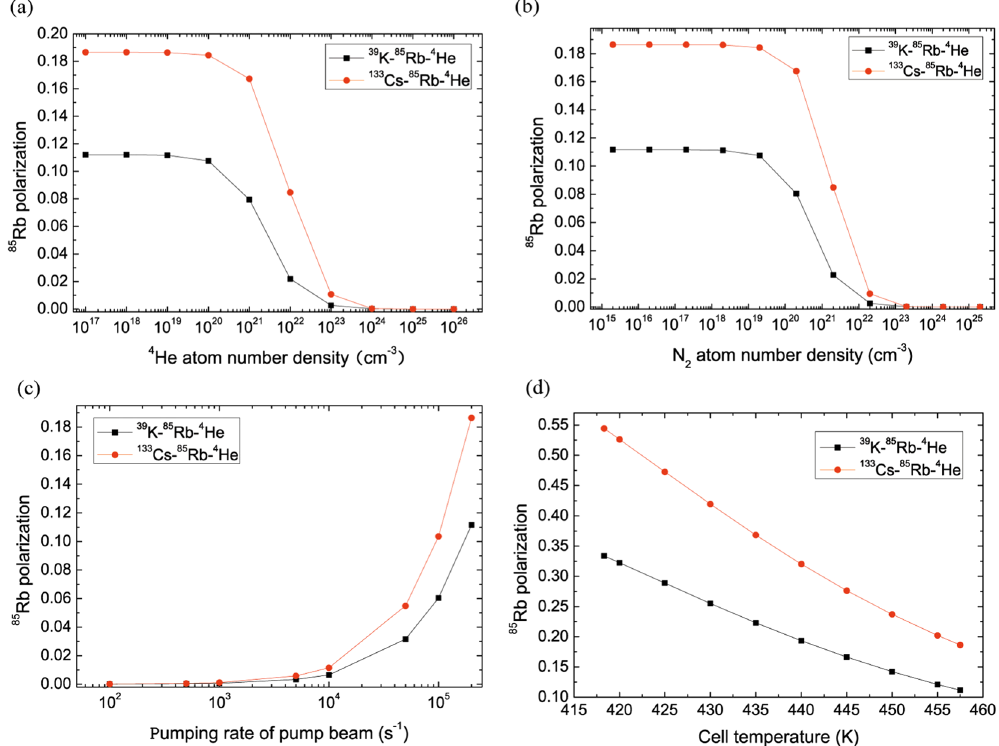
Figure 2. The 85 Rb polarization of 39 K ( 133 Cs)- 85 Rb- 4 He magnetometers varies with the number density of the buffer gas ( 4 He), the pumping rate of pump beam, number density of the quench gas N 2 and the cell temperature respectively. ( a ) 85 Rb polarization almost does not vary with the increasing 4 He number density when 4 He number density is smaller than a critical value about 10 20 cm − 3 in 39 K - 85 Rb- 4 He (black line in squares) and 133 Cs- 85 Rb- 4 He (red line in dots) magnetometers, otherwise, 85 Rb polarization decreases rapidly. ( b ) 85 Rb polarization almost does not vary with increasing N 2 number density when N 2 number density is smaller than about 2 × 10 19 cm − 3 in 39 K- 85 Rb- 4 He and 133 Cs- 85 Rb- 4 He magnetometers, otherwise, the 85 Rb polarization decreases rapidly. ( c ) 85 Rb polarization increases with increasing R pK and R pCs respectively. ( d ) 85 Rb polarization decreases with the increasing cell temperature. The 85 Rb polarization of 133 Cs- 85 Rb- 4 He magnetometer is bigger than the one of 39 K- 85 Rb- 4 He magnetometer in ( a )–( d